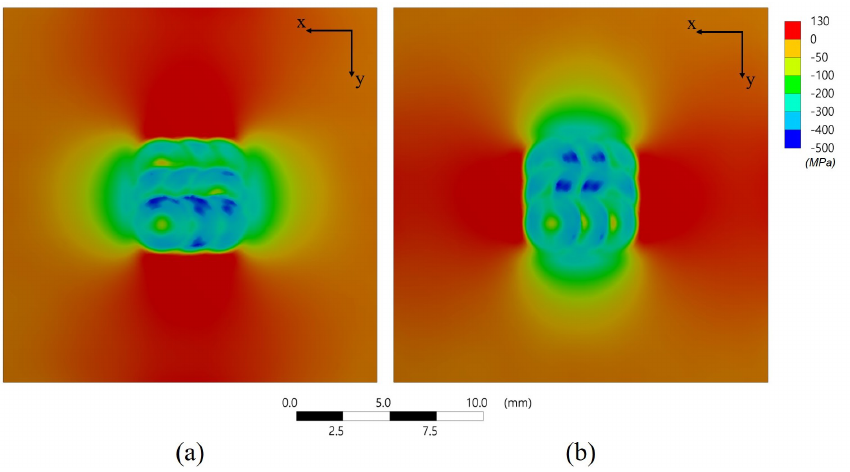
Figure 19. Residual stress of the geometry surface ( R d = 0): ( a ) normal stress σ x and ( b ) normal stress σ y .